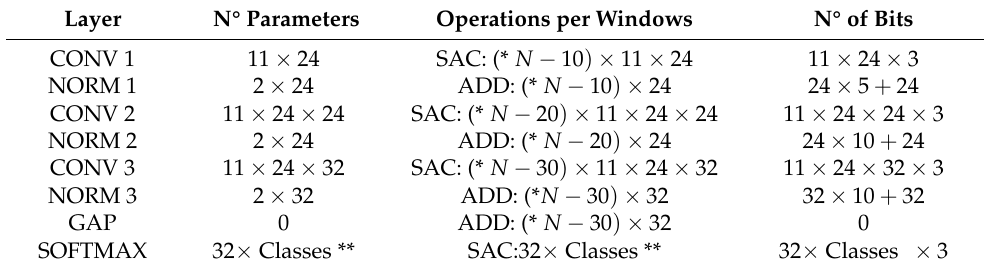
Table 1. Complexity of the proposed